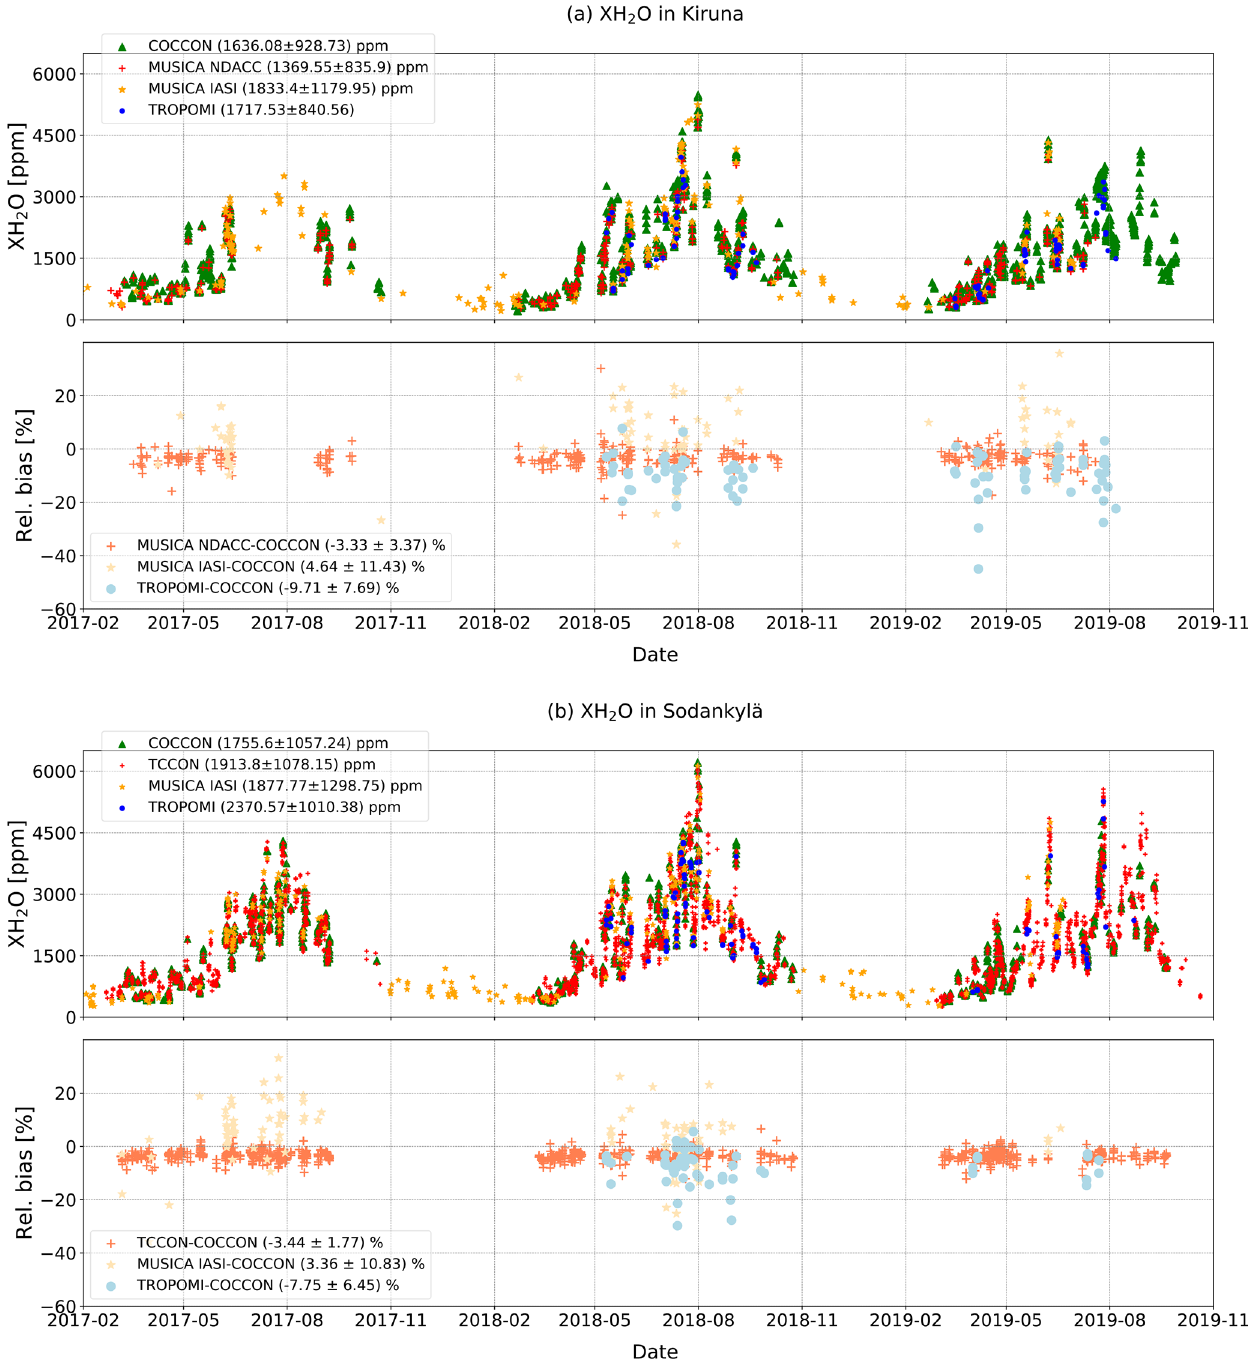
Figure 1. Time series of XH 2 O derived from MUSICA IASI, TROPOMI, and ground-based FTIR instruments at (a) Kiruna and (b) So- dankylä. The corresponding relative biases are presented in the bottom panel for coincident pairs in each